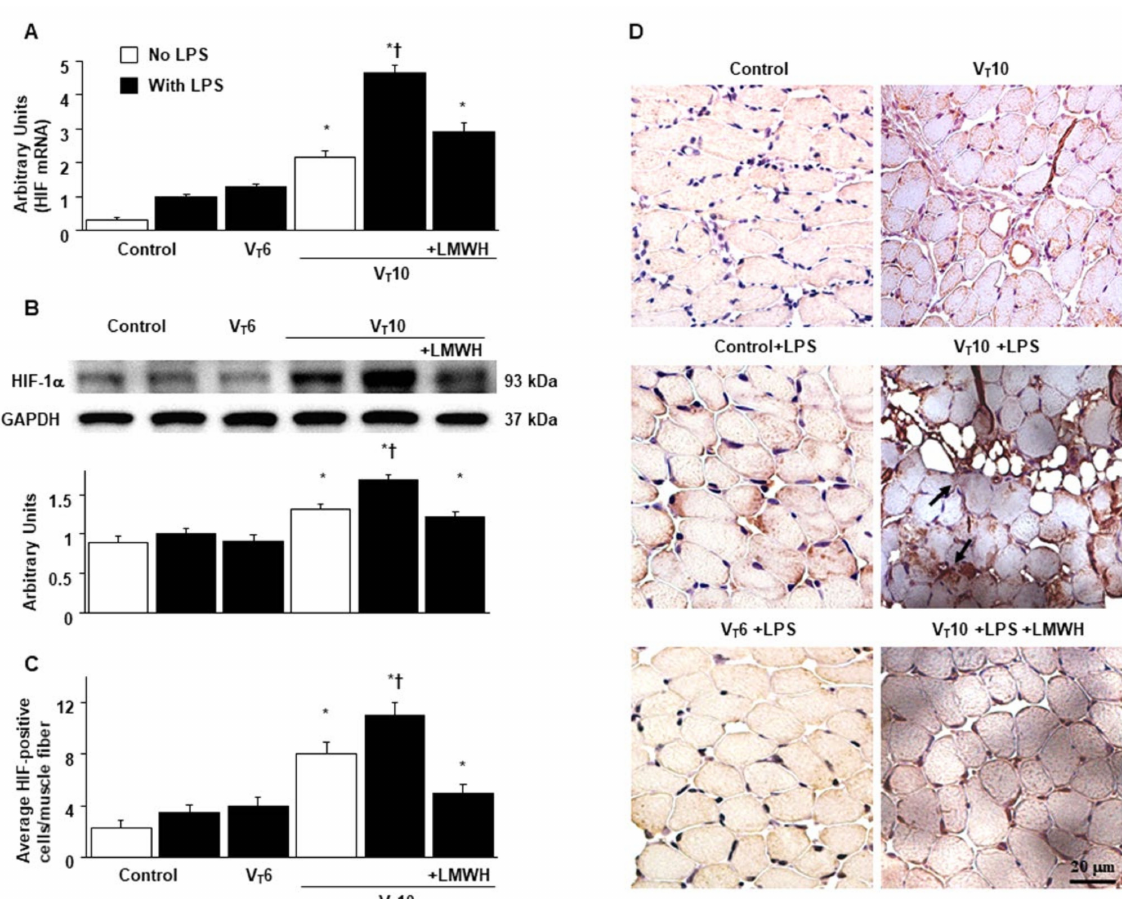
Figure 4. Suppression of endotoxin-augmented mechanical ventilation-induced HIF-1 α mRNA activation and HIF-1 α protein expression by enoxaparin. ( A ) Real-time PCR performed for HIF-1 α mRNA expression was from the diaphragms of non-ventilated control mice and mice ventilated at a tidal volume of 6 mL/kg or 10 mL/kg for 8 h with or without LPS administration (n = 5 per group). Arbitrary units were expressed as the ratio of HIF-1 α mRNA to GAPDH (n = 5 per group). ( B ) Western blots from the same animals were conducted using antibodies that recognize HIF and GAPDH expression from the diaphragms of non-ventilated control mice and mice ventilated at a tidal volume of 6 mL/kg or 10 mL/kg for 8 h with or without LPS administration (n = 5 per group). Arbitrary units were expressed as the ratio of HIF-1 α to GAPDH (n = 5 per group). ( C and D ) Representative micrographs ( × 400) with HIF-1 α staining of paraffin lung sections and quantification were from non-ventilated control mice and mice ventilated at a tidal volume of 6 mL/kg or 10 mL/kg for 8 h with or without LPS administration (n = 5 per group). Enoxaparin, 4 mg/kg, was given subcutaneously 30 min before mechanical ventilation. Scale bars represent 20 µ m. * p < 0.05 versus the non-ventilated control mice with LPS treatment; † p < 0.05 versus all other